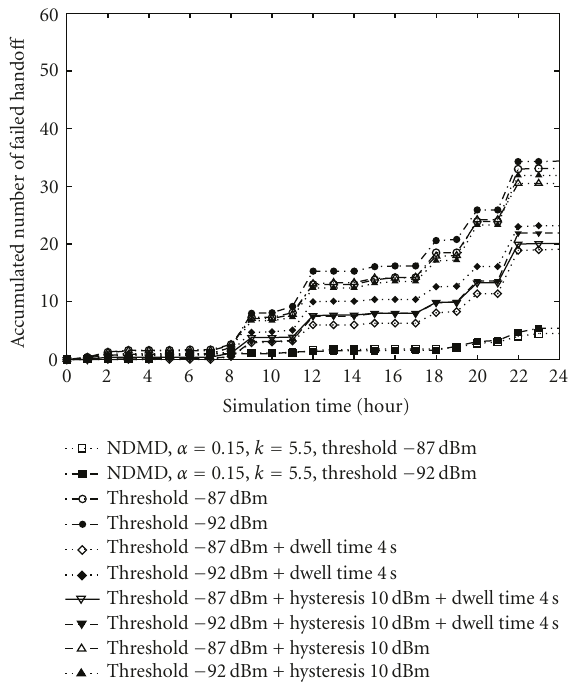
Figure 24: Accumulated number of failed hando ff in WLAN.